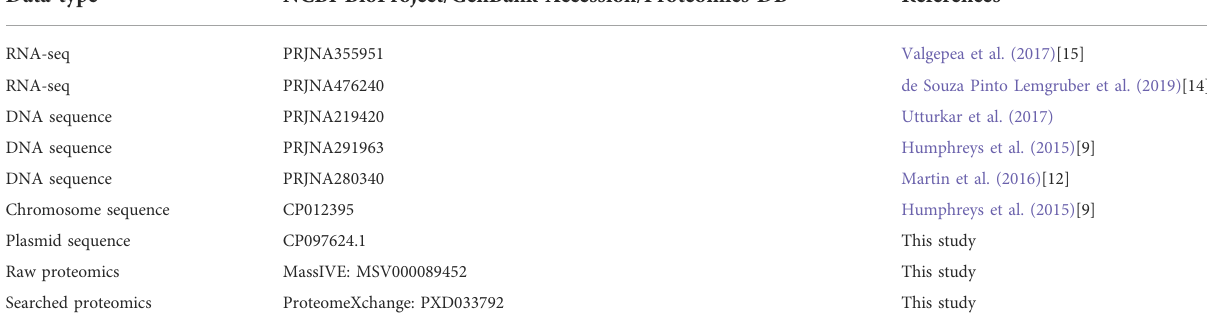
TABLE 1 Sequences and chromosome data sources.